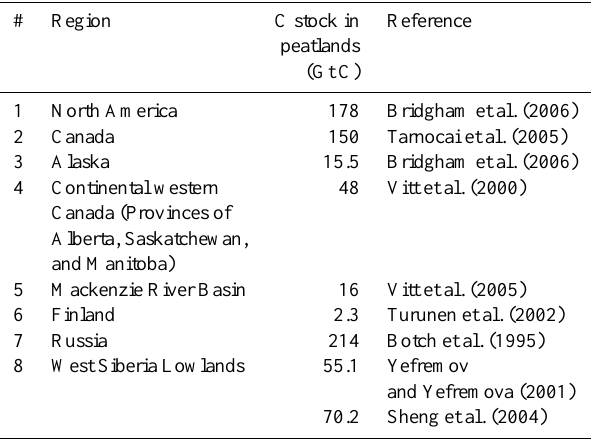
Table 3. Estimates of carbon stocks in peatlands of different re-